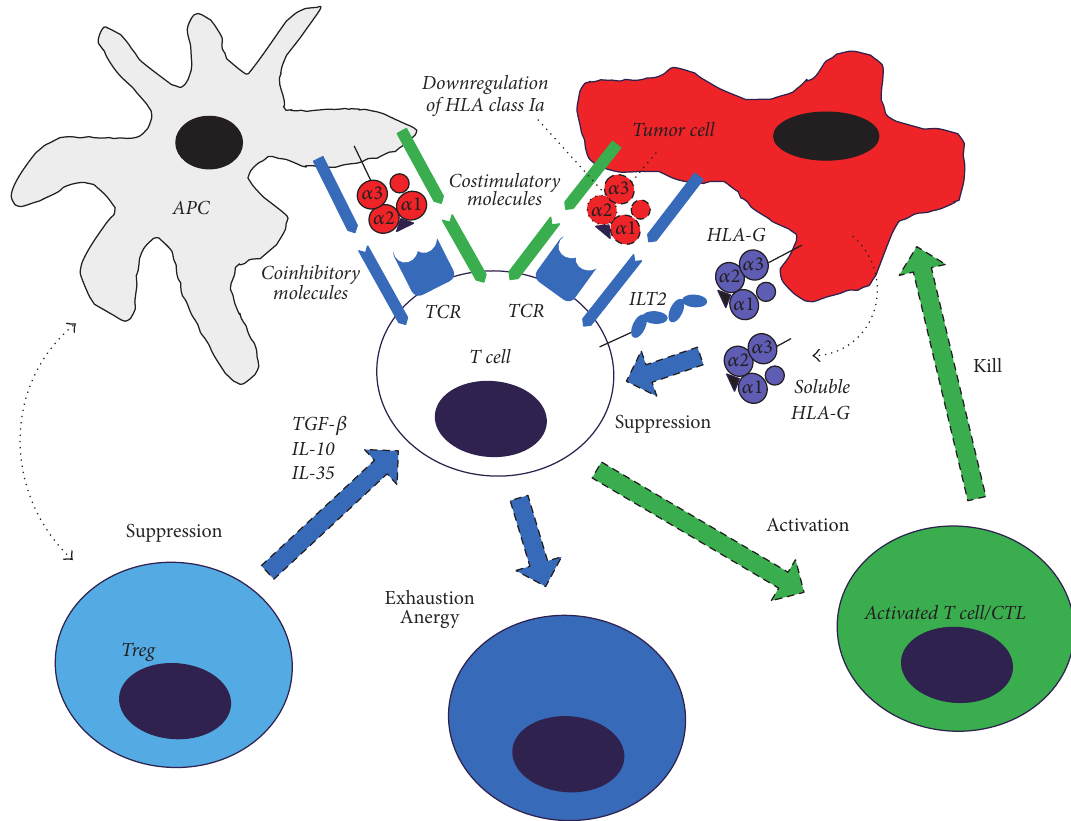
Figure 2: Schematic representation of immunological mechanisms discussed in the text that may lead to escape of malignant melanoma cells from immune surveillance. The expression of HLA class Ia molecules on the tumor cell surface may be compromised or downregulated. The tumor cell may begin, or may be selected, to express immunosuppressive HLA-G molecules that exist in both membrane-bound forms and soluble forms. Regulatory T cells in the tumor microenvironment secrete TGF- 𝛽 , IL-10, and IL-35 that inhibit T cell functions. If the immune checkpoint balance is in favor of negative signals, it will result in inhibition of T cell responses with exhausted T cells and cytotoxic T lymphocytes in anergy (APC: antigen-presenting cell; CTL: cytotoxic T lymphocyte; IL-10: interleukin-10; IL-35: interleukin-35; ILT2: immunoglobulin-like transcript-2; TCR: T cell receptor; TGF- 𝛽 : transforming growth factor- 𝛽 ; Treg: regulatory T